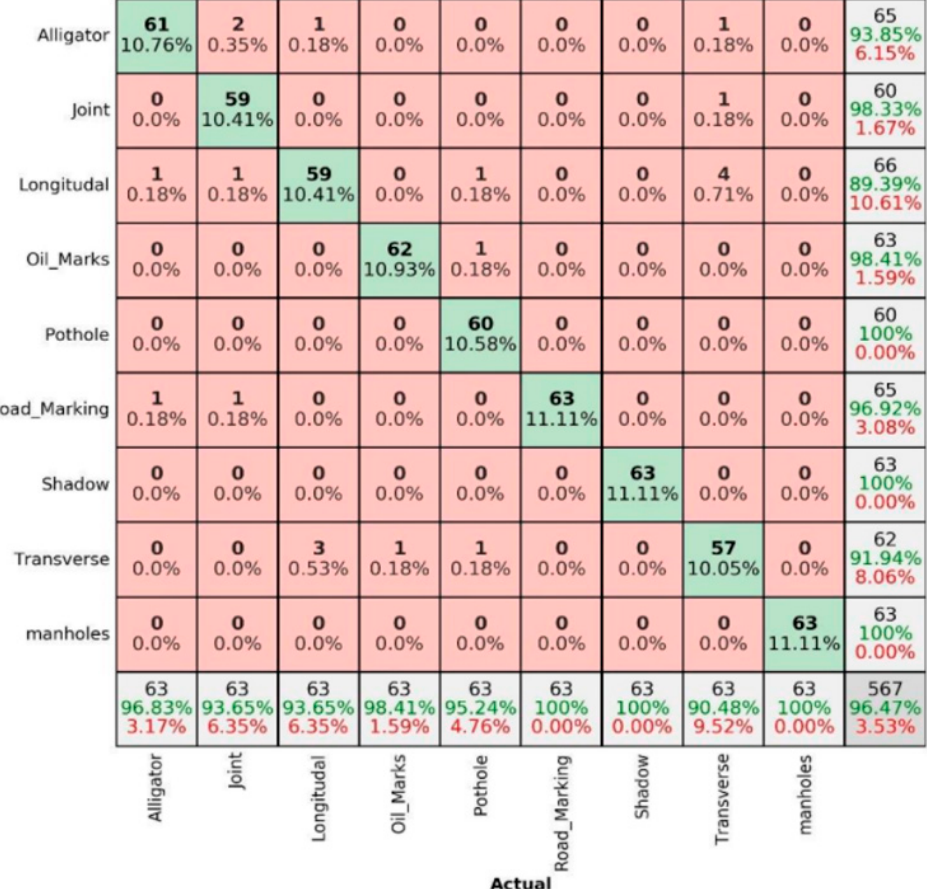
Figure 7. Summer sunny condition—DC images.